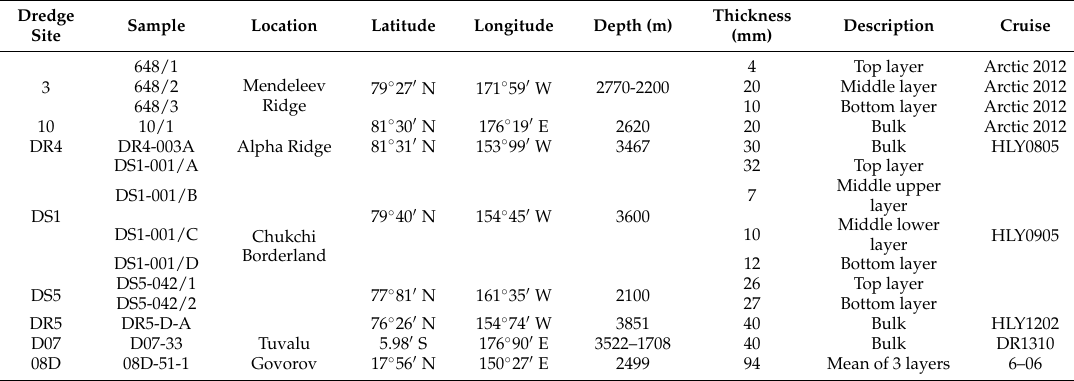
Figure 2. Location map of the Amerasia basin, Arctic Ocean (dashed line inset); dredge sites of crusts studied here from samples collected on Russian (red circles) and USA (dark blue squares) cruises. Table 2. Crust samples selected for sequential leaching experiments.